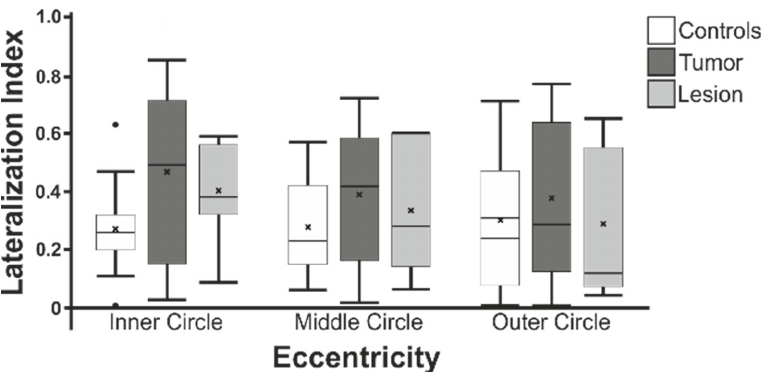
Figure 8. Absolute Lateralization Indices measures within the occipital lobe within the control, tumor patient and lesion patient groups.